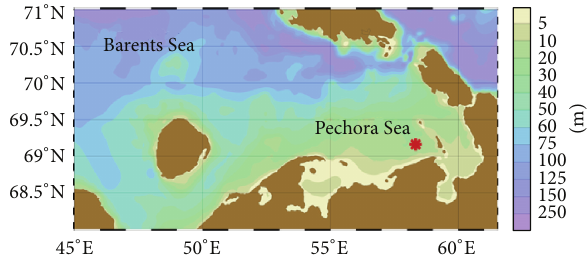
Figure 1: Bathymetric map of the Pechora Sea. The place of obser- vations is marked by red